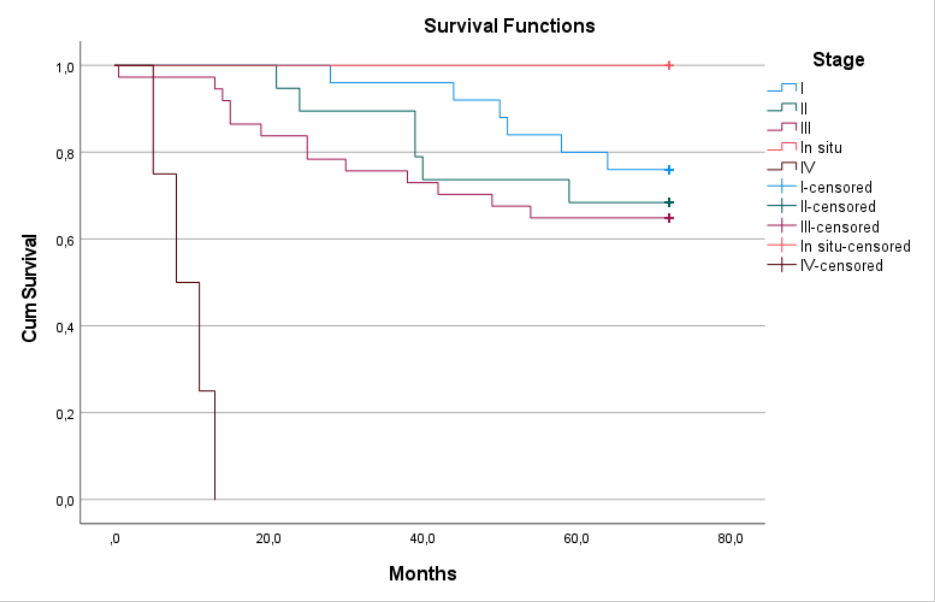
Figure 3. 6-year overall survival between pathological stages.